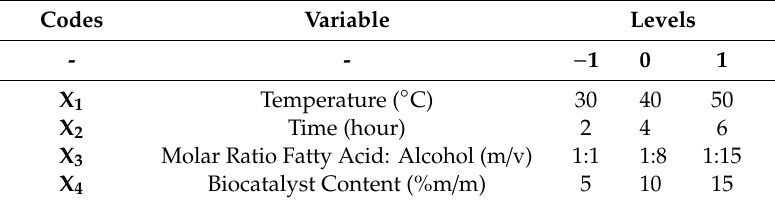
Table 9. Numerical and coded values of the variables adopted in the experimental design for the esterification of the free fatty acids of residual babassu oil. Codes Variable Levels - - −